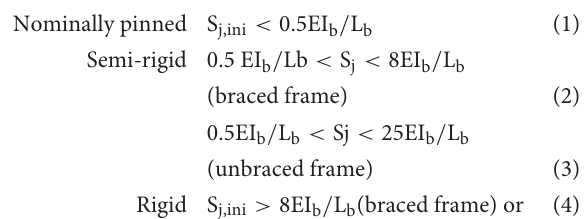
FIGURE 1 | Rendering of the reference connection, figure based on Karagiannis et al. (2017).